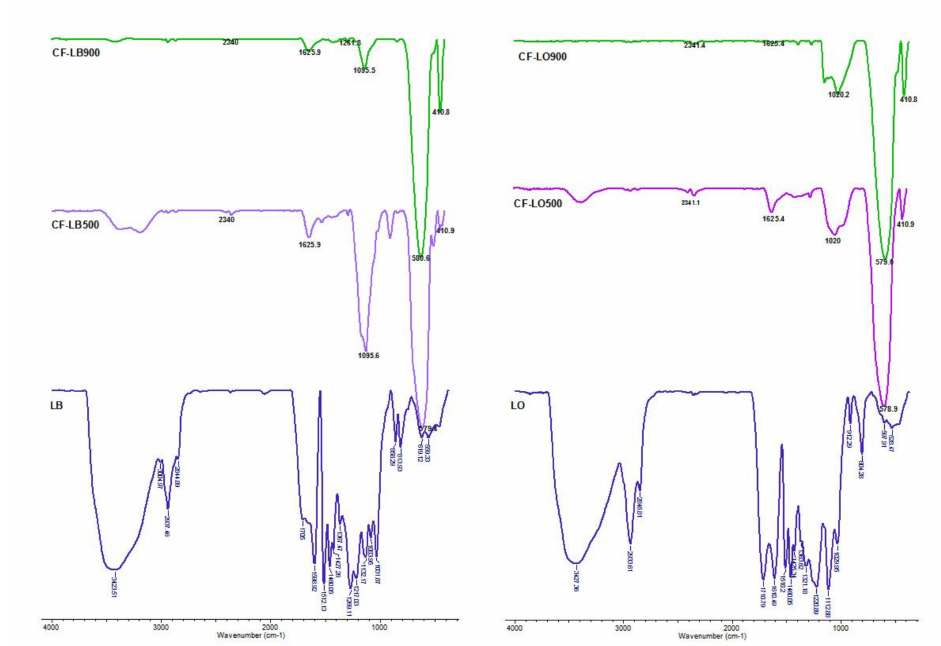
Figure 1. FTIR spectra of lignin